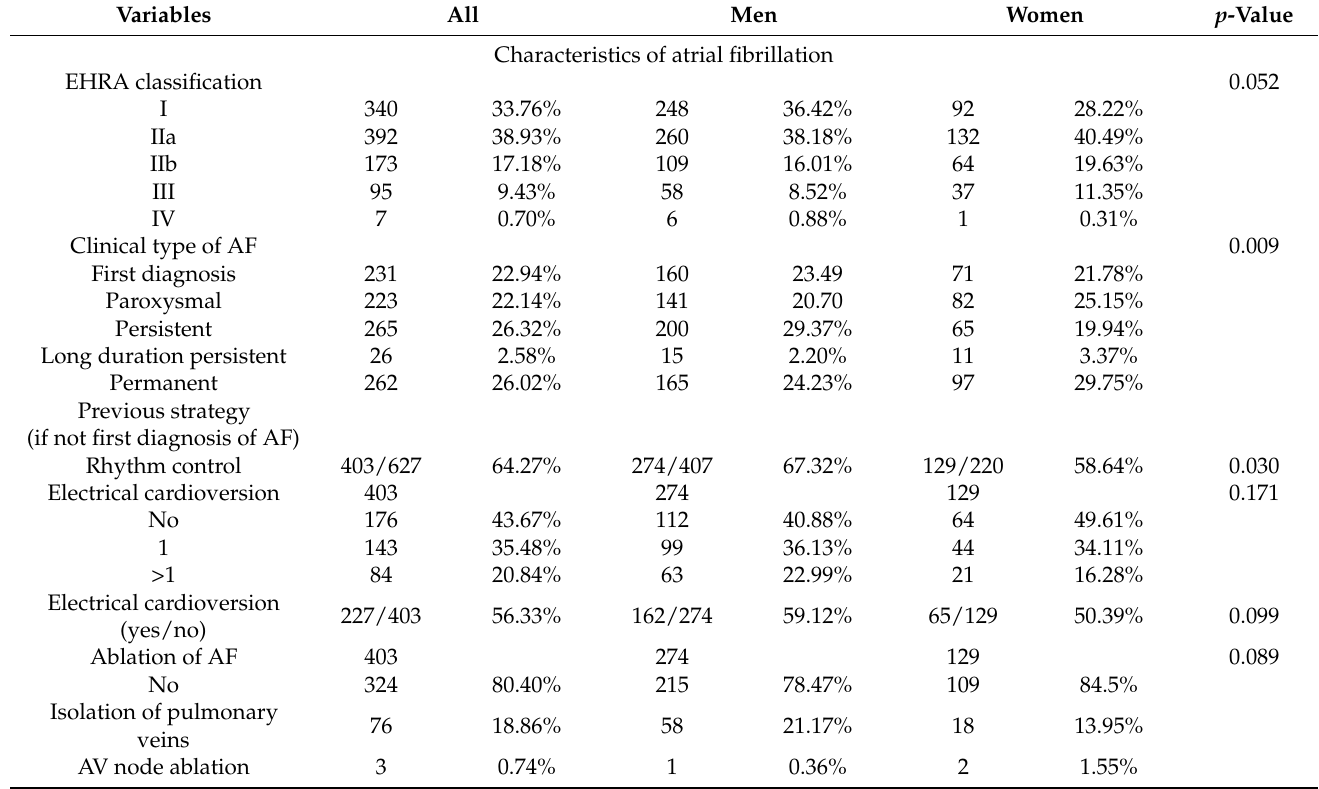
Table 6. Characteristics of previous atrial fibrillation management